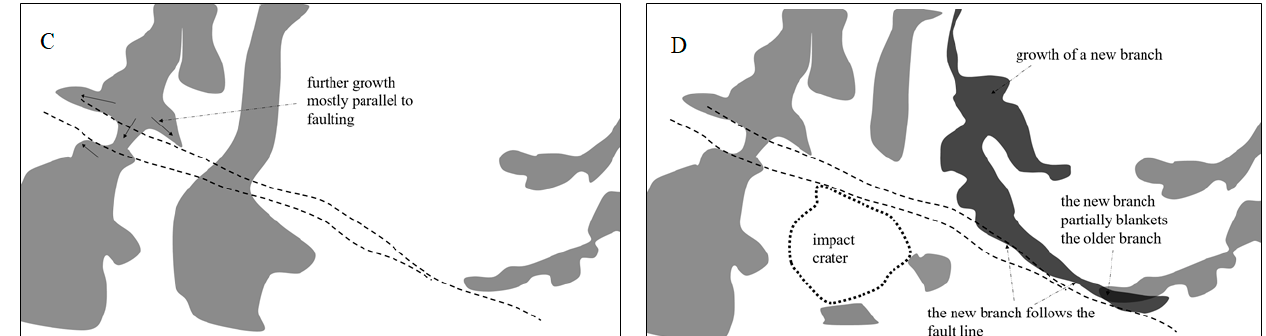
Figure 15. Interpretative scheme of the evolution of the area shown in Figure 12. ( A ) Initially, dendrites have grown from different branches. ( B ) Faulting occurs and some branches are split up. ( C ) Further growth occurs parallel to the fault lines; in addition, a bridge between the edges of previously separated dendrites is created. ( D ) A new branch develops and propagates parallel to the fault line, ending up superposing to a previous branch.